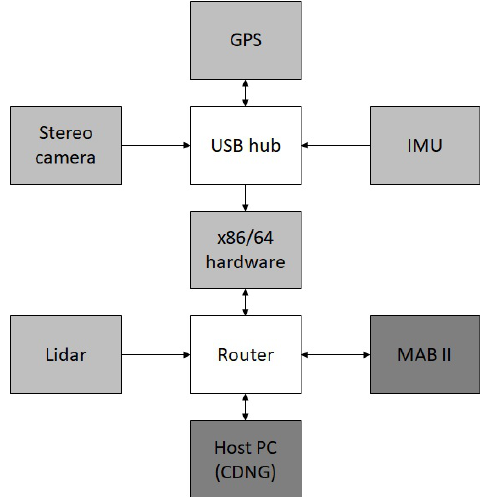
Fig. 5. Schematic of the hardware architecture of the